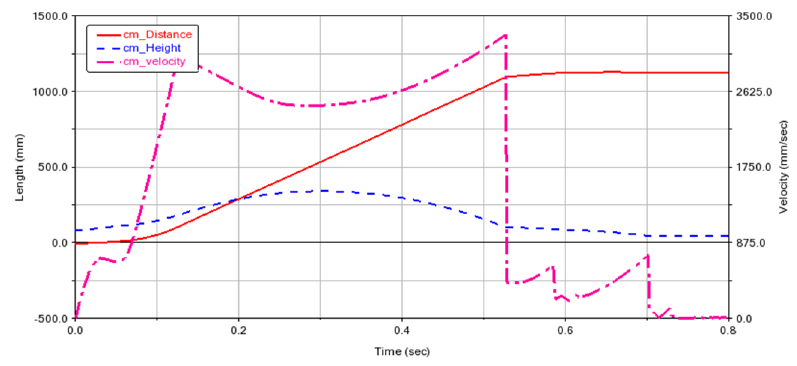
Figure 6. Simulation results of jumping motion of simplified frog mechanism model.